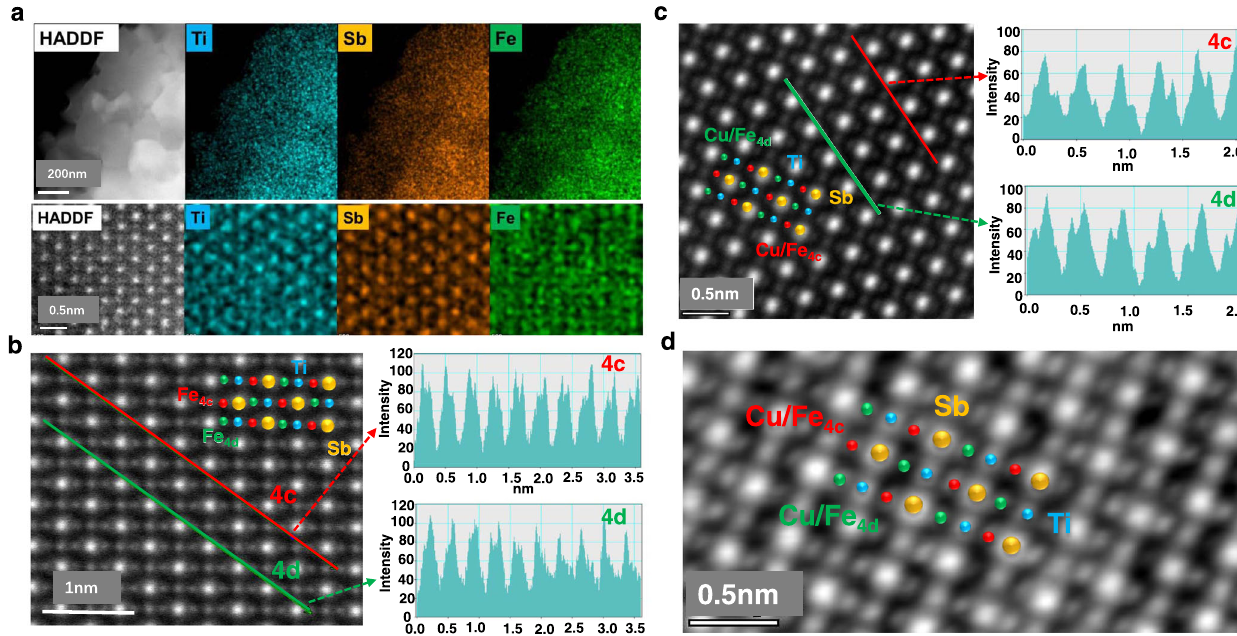
Fig. 4 Microstructures of TiFe 0.7 Cu 0.4 Sb and TiFe 1.33 Sb. a HAADF-STEM image and corresponding EDS maps for TiFe 1.33 Sb. b , c Aberration correction high-resolution HAADF image along a [110] direction and the corresponding intensity pro fi les across the horizontal lines for TiFe 1.33 Sb and TiFe 0.7 Cu 0.4 Sb, respectively. d iDPC image along a [110] direction of the TiFe 0.7 Cu 0.4 Sb sample.